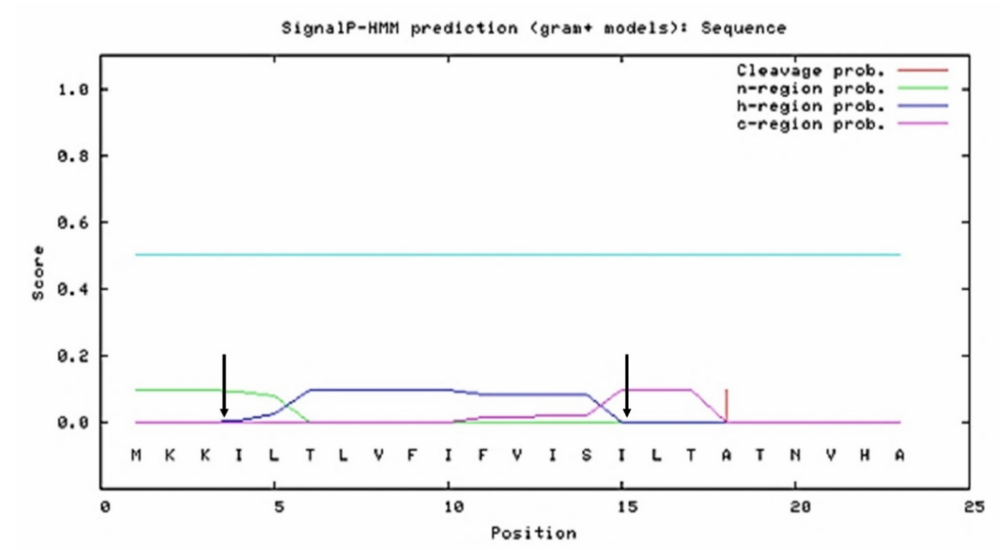
Figure 2. Graphical output of predicted N-, H-, and C-domain regions of the SPK1 using SignalP 3.0 server showing the SP harbour N-domain region from residue 1–3 (green line), H-domain region from residue 4–15 (blue line), and C-domain region from residue 16–23 (purple line). Arrow indicates separations between N-, H-, and C-domains,